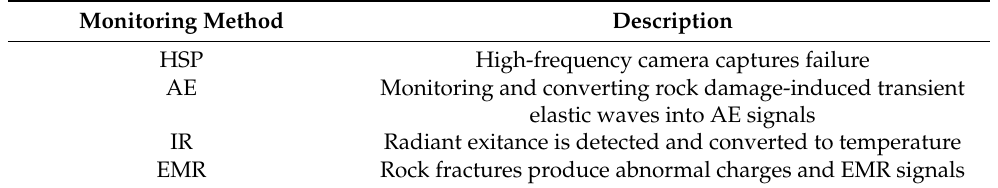
Table 5. Summary of monitoring technologies for rockburst tests [71].